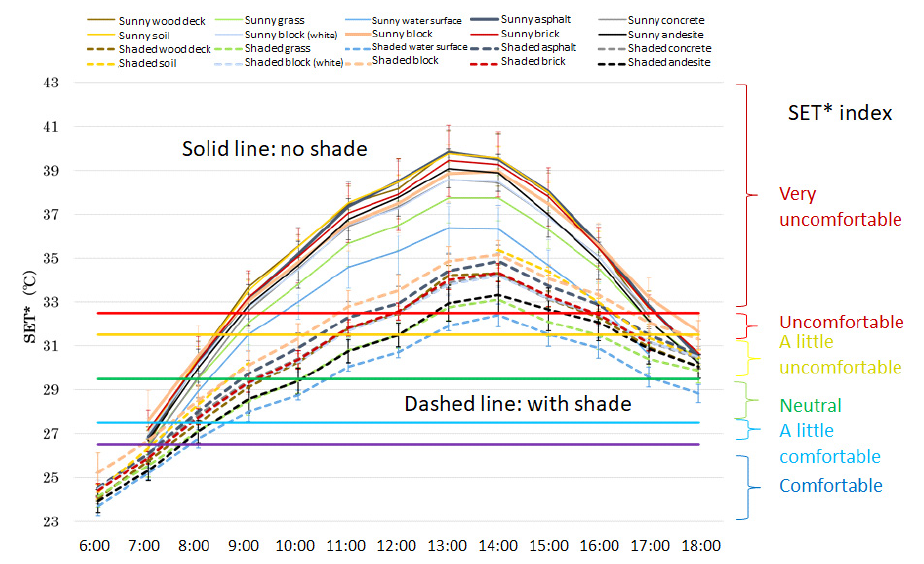
Figure 11. Diurnal variation of modeled SET* at 1.5 m height on each land cover on 5 August 2019.